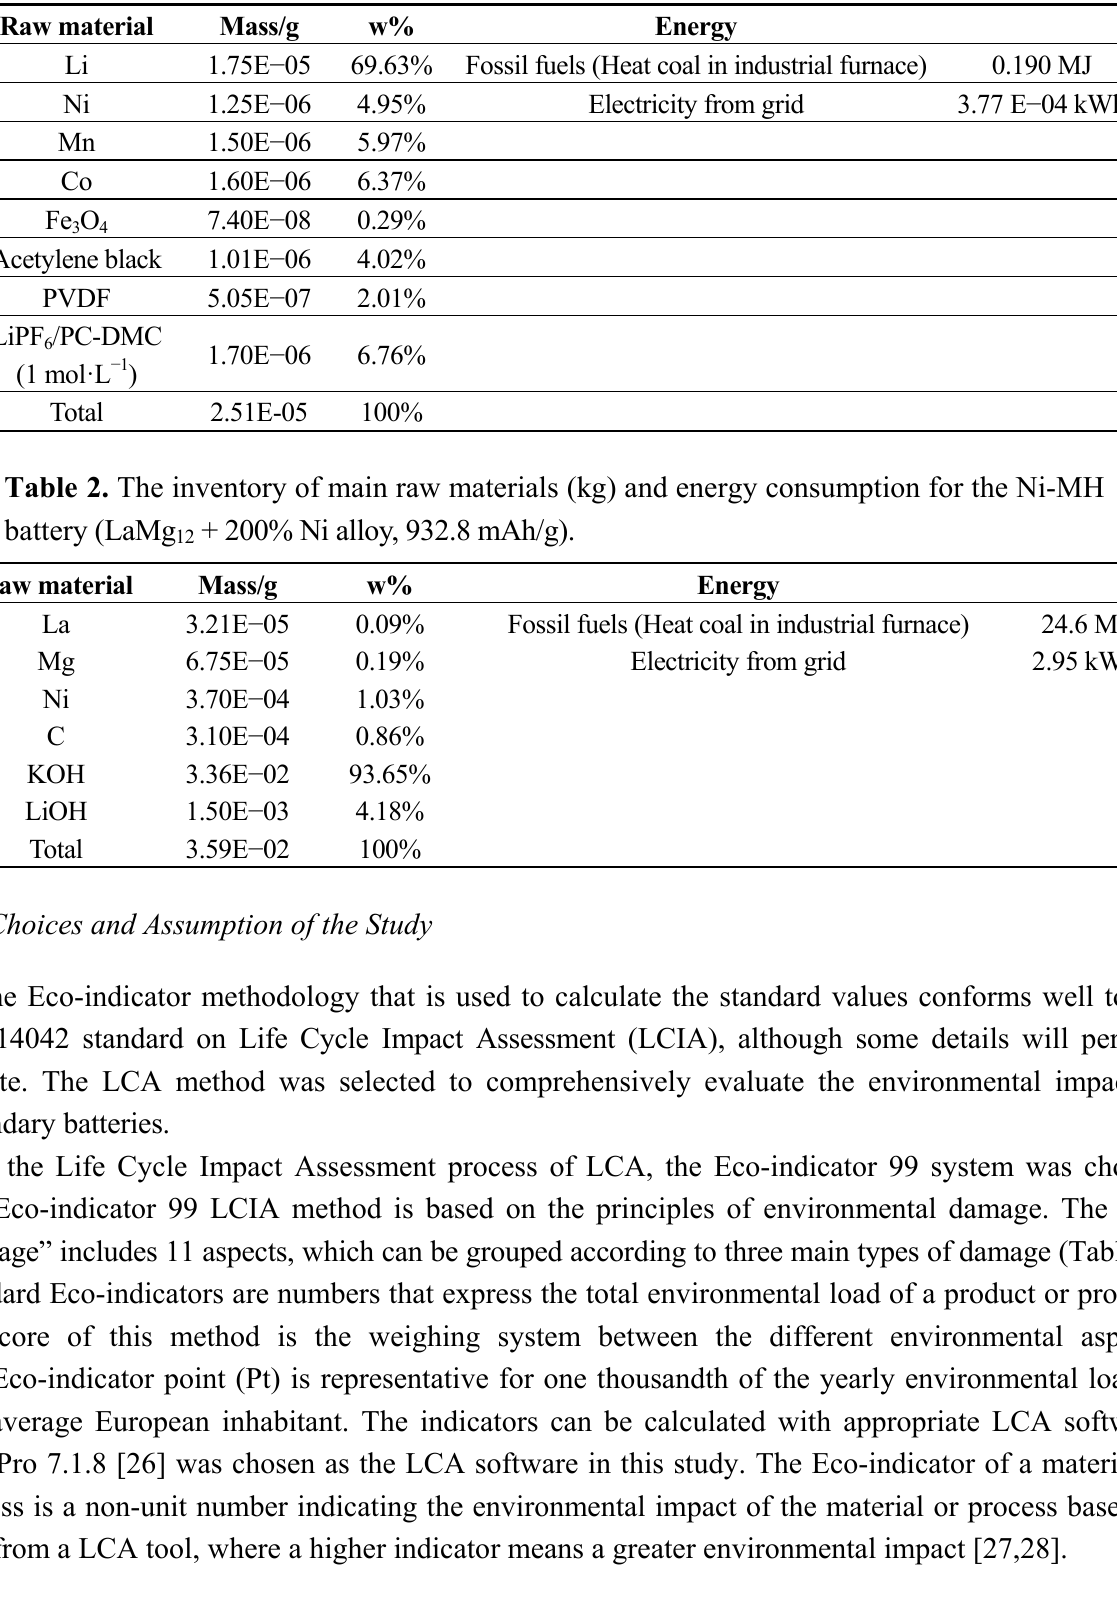
Table 1. The inventory of main raw materials (kg) and energy consumption for the